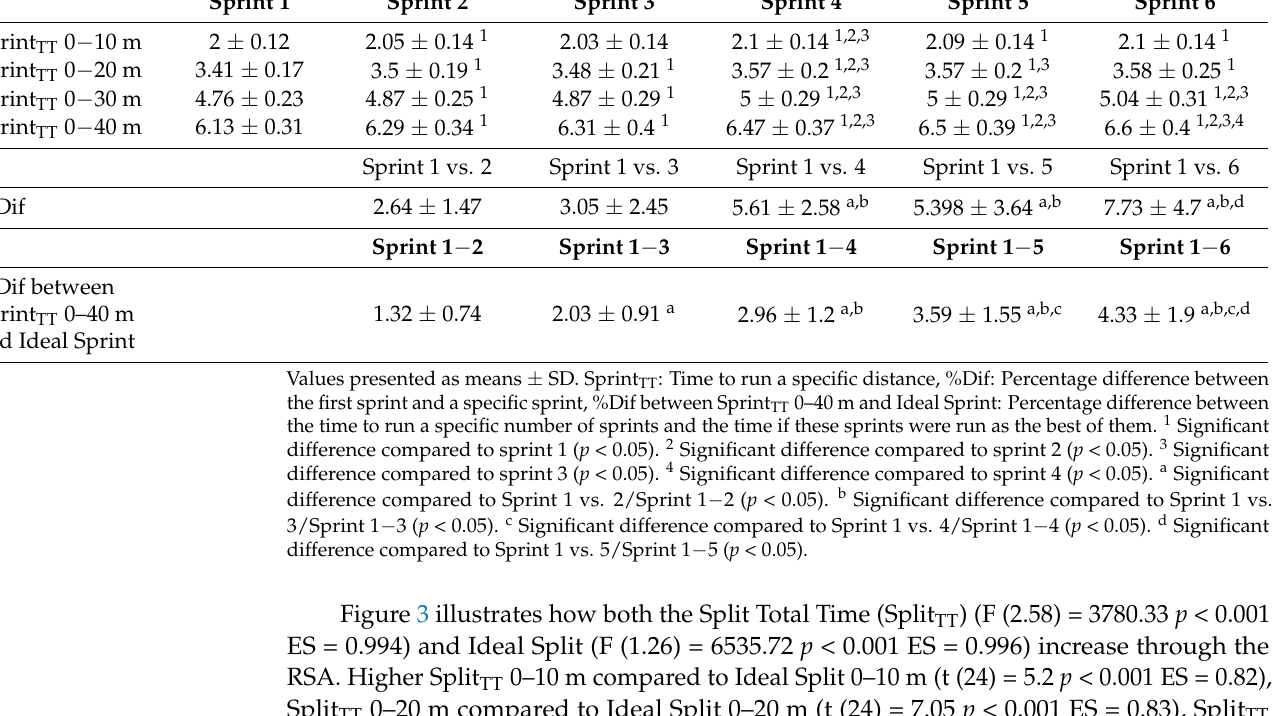
Table 3 . Performance variables of the repeated sprint ability.